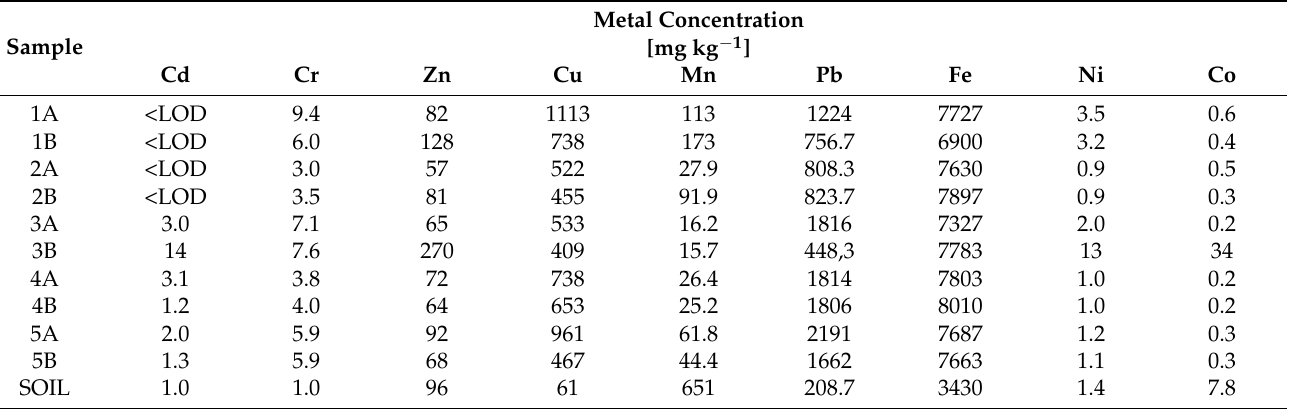
Table 4. The results of the determinations of the heavy metals concentrations in the material collected from the Ilba mining